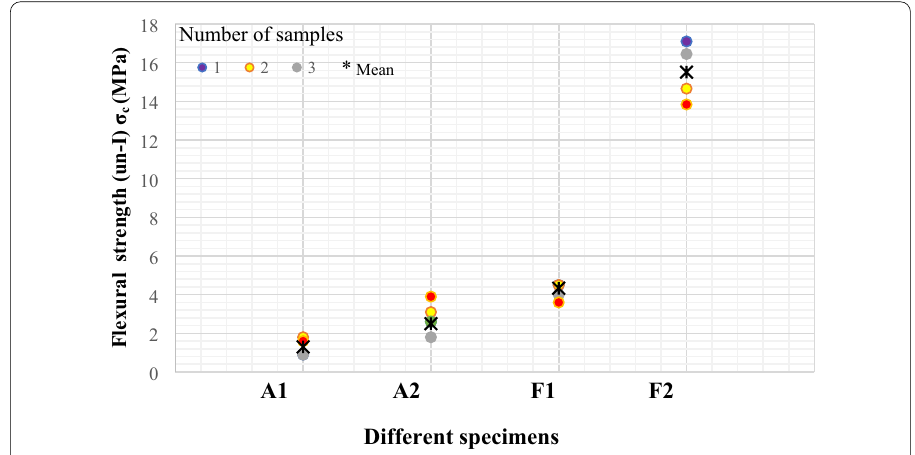
Fig. 6 Flexural strength of dry specimens according to the different facies. Kaol: kaolinite; Boe: Boemite; Gib: